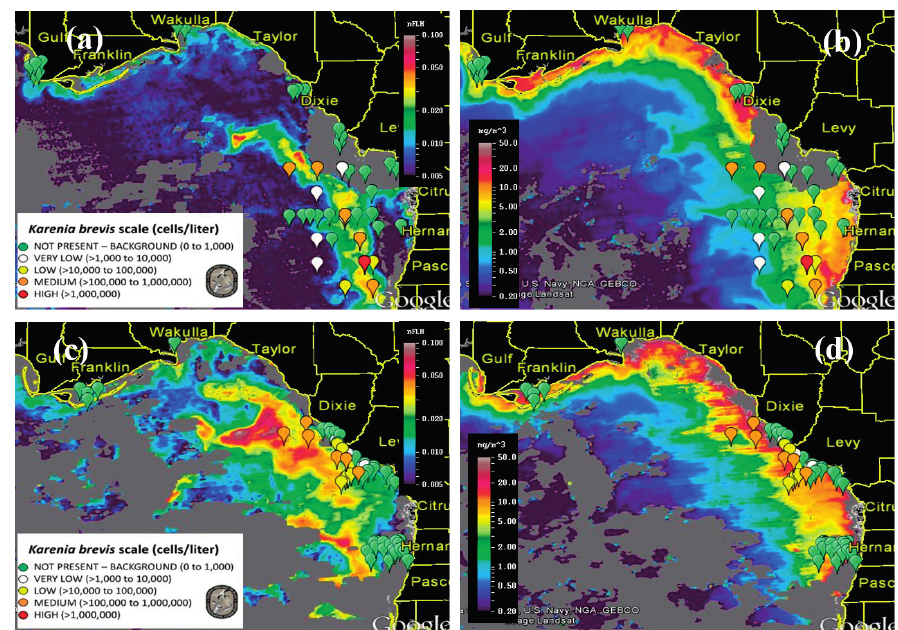
Figure 8. MODISA nFLH and Chla images on 2 September 2014 ( a , b ) and on 14 September 2014 ( c , d ), annotated with K. brevis concentration data between 27 August and 3 September ( a , b ) and between 10 September and 17 September ( c , d ). ( a , c ) are examples of the FWC HAB bulletins distributed weekly or twice weekly. Gray represents clouds or invalid data. More examples can be found in the Supplemental